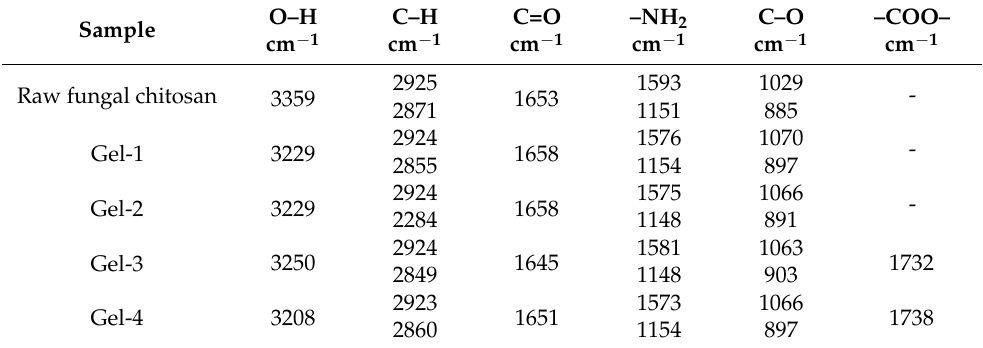
Figure 8. General scheme of hemostatic agent preparation (*—another polymeric unit) Table 3. FTIR results.